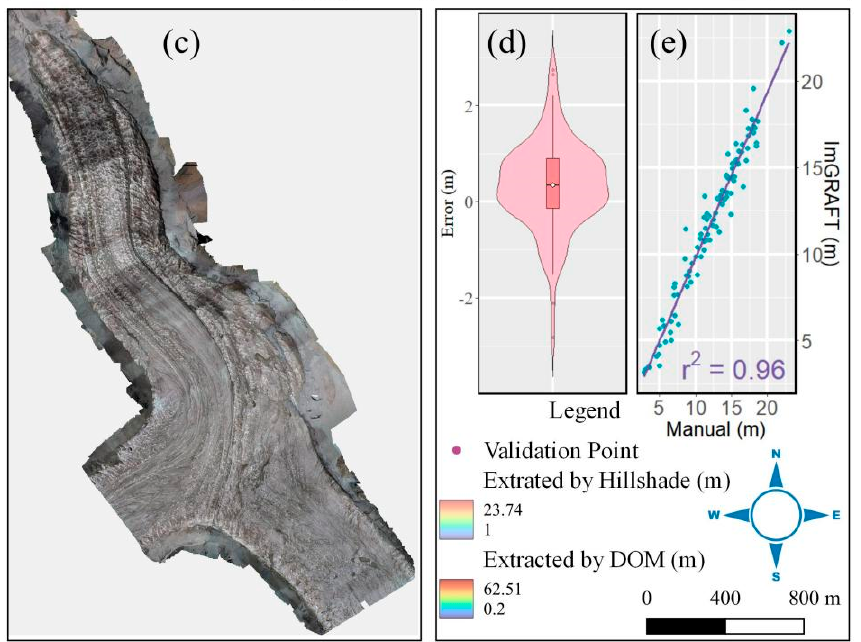
Figure 2. Method test and uncertainty estimation of surface velocity extraction of LHG12. ( a ) Surface velocity extracted by DSM; ( b ) Surface velocity extracted by hillshade images and distribution of validation points; ( c ) DOM acquired on 16 July 2019; ( d ) Surface velocity extraction errors between ImGRAFT and artificial; ( e ) Relativity of surface velocity extracted by ImGRAFT and artificial.